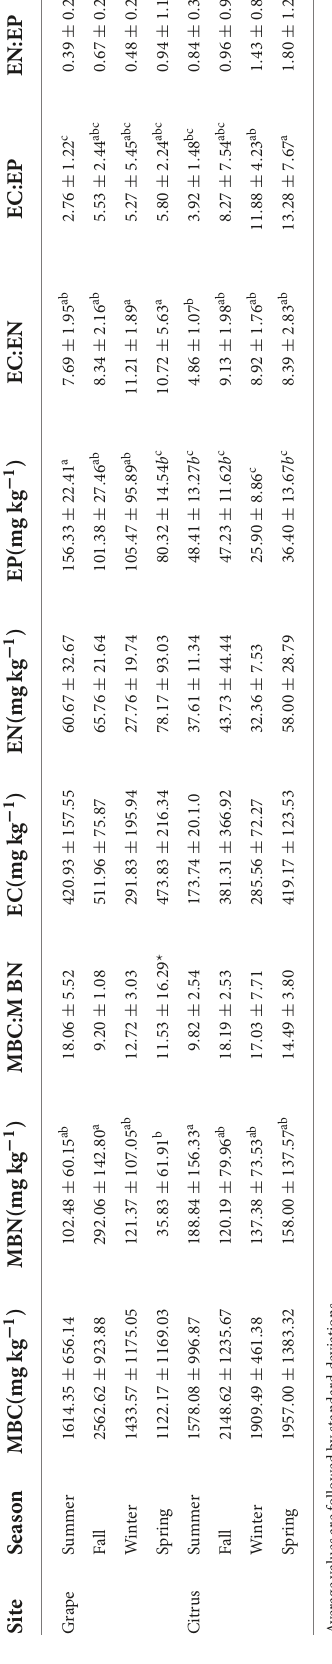
Table 2 . Assuming a constant C 2 H 4 :N 2 conversion factor and using experimental ratios, the N 2 -fixation rates in Grape